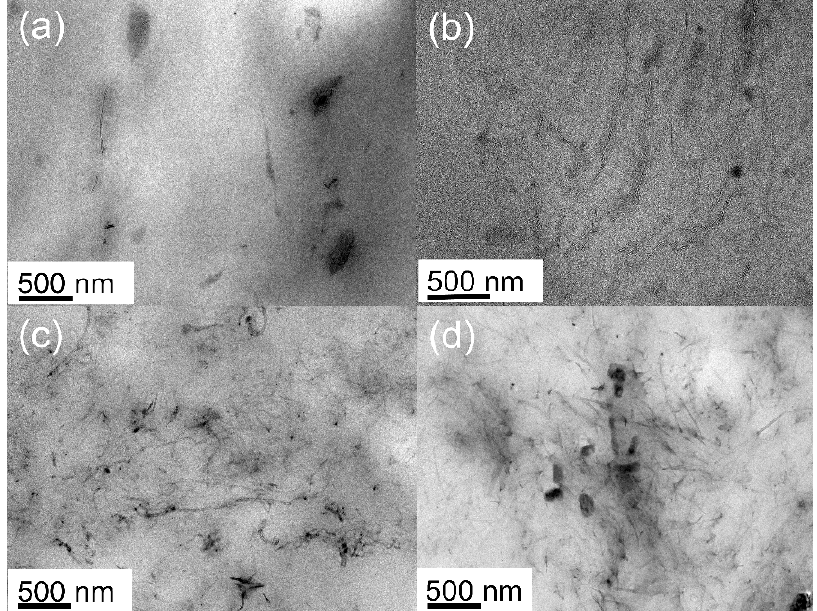
Figure 6. HRTEM images of CNTs/MXene/TPU composite: ( a ) 0.1 wt% MXene/0.2 wt% CNTs, ( b ) 0.25 wt% MXene/0.4 wt% CNTs, ( c ) 0.5 wt% MXene/0.6 wt% CNTs, ( d ) 1 wt% MXene/0.8 wt% CNTs.